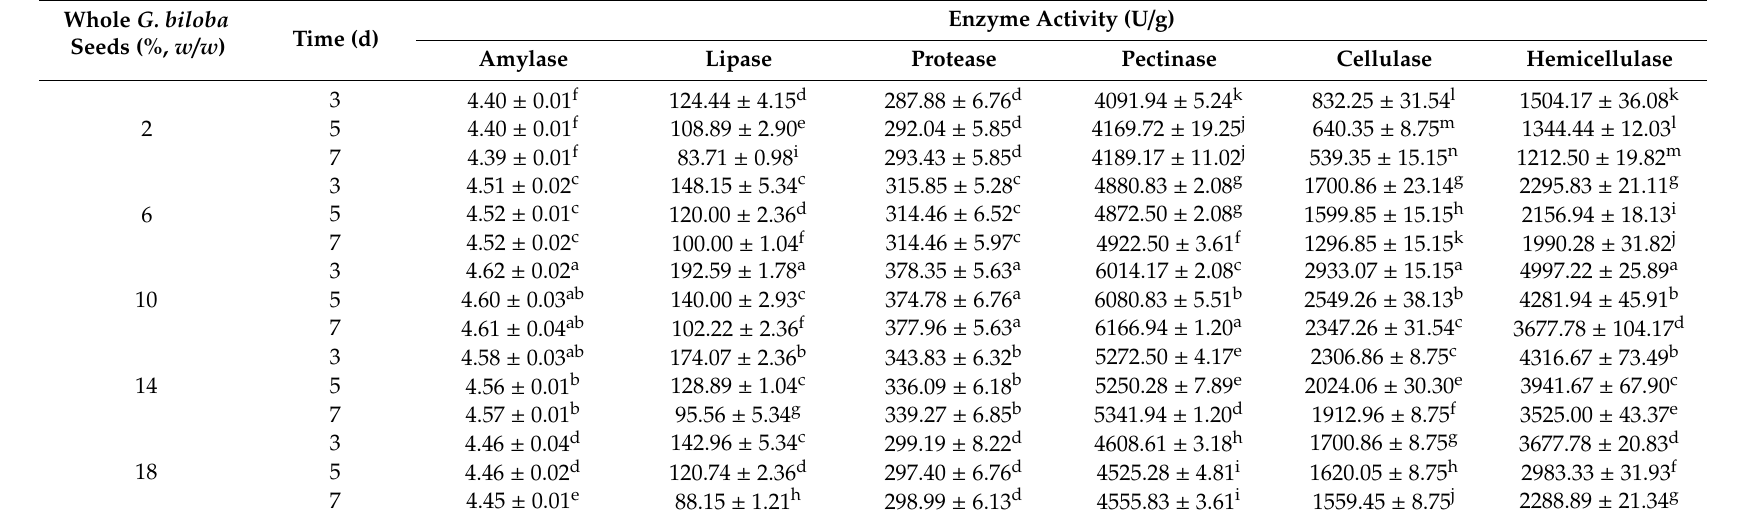
Table 3. E ff ects of varying amounts of whole G. biloba seeds on the activities of several enzymes in fermented G. biloba leaves. Whole G.